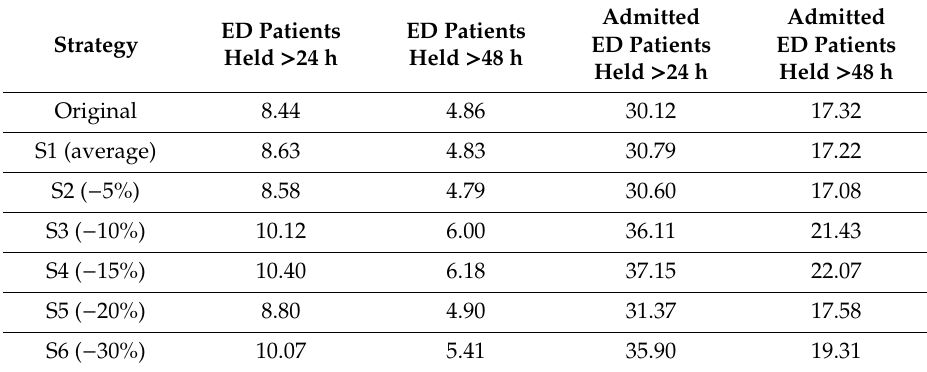
Table 3. ED overcrowding indicators in di ff erent